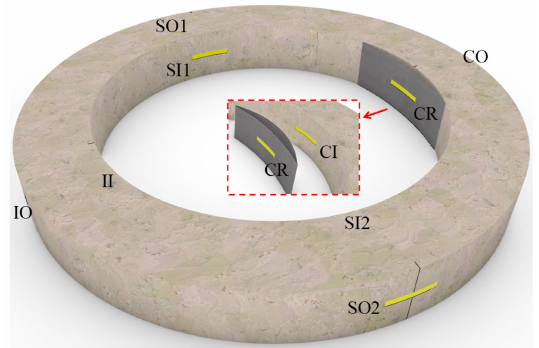
Figure 7. Positions and codes of strain gauges.